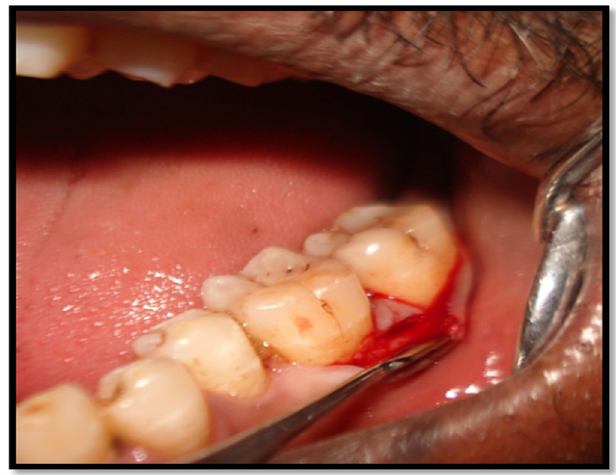
Figure 2. Single flap incision technique (buccal single incision placed).